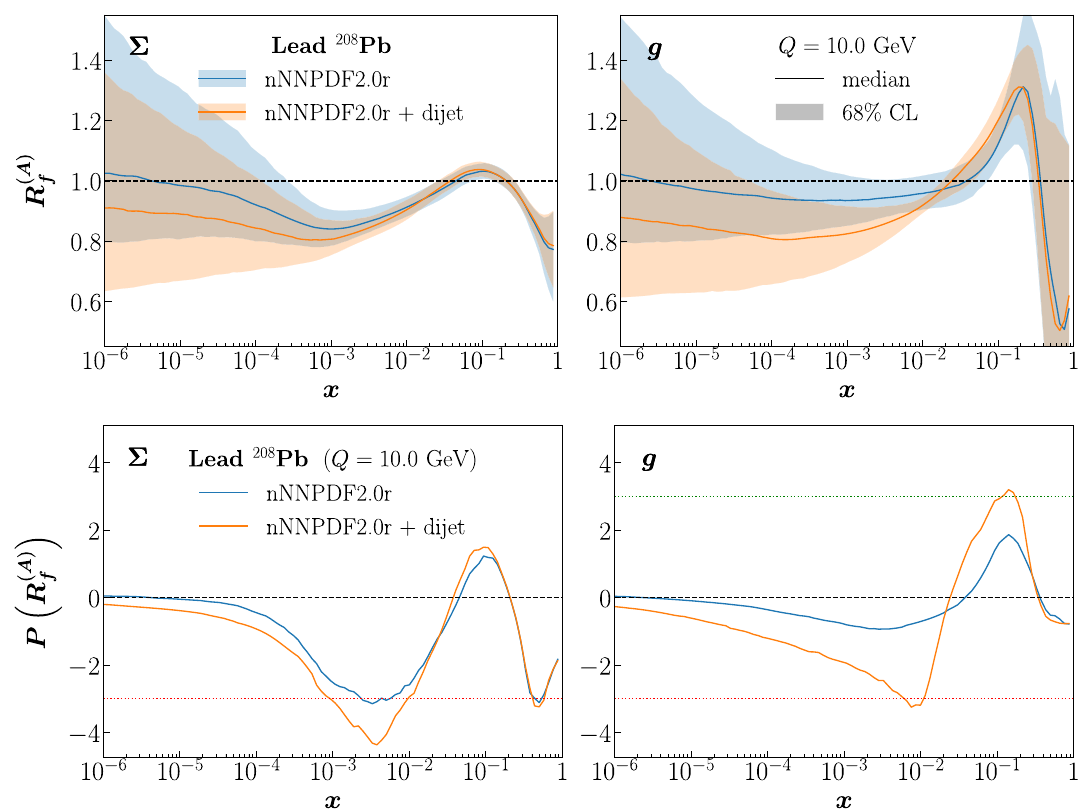
Fig. 23 The impact of the CMS dijet pPb-to-pp ratio measurements at 5.02 TeV on the quark singlet (left) and gluon (right panel) nPDFs of lead. We display results for the nuclear modification factors R ( A ) ( x , Q ) at Q = 10 GeV, comparing the nNNPDF2.0r fit with the variant includ-